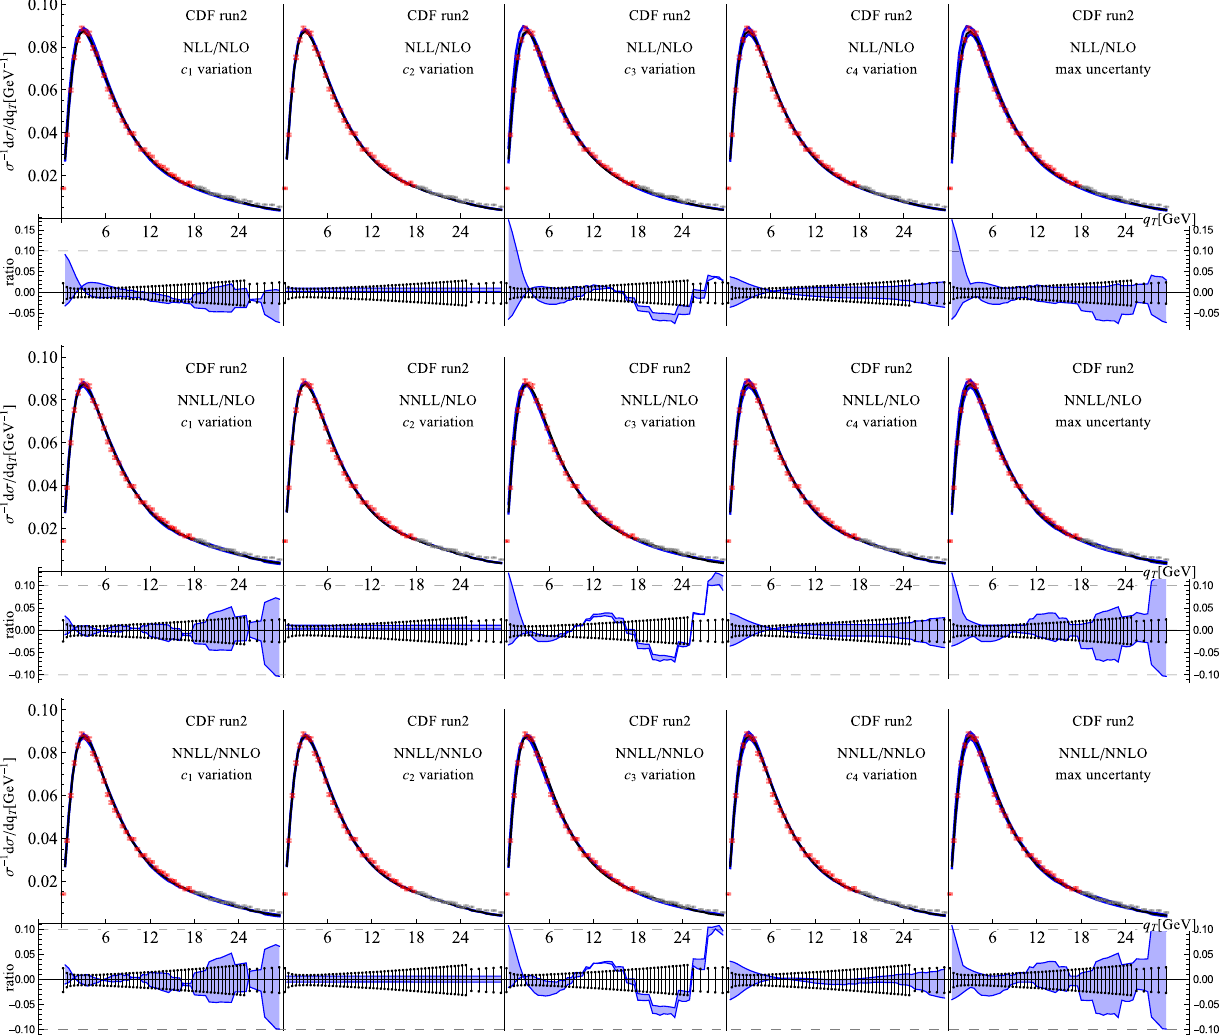
Fig. 4 Theoretical error-bands and experimental data points for CDF- Run2 experiment. Thetheoreticalerroris estimatedchanging c 1 , 2 , 3 , 4 in therange ( 0 . 5 , 2 ) ateachperturbative order. Thenonpertubative inputis